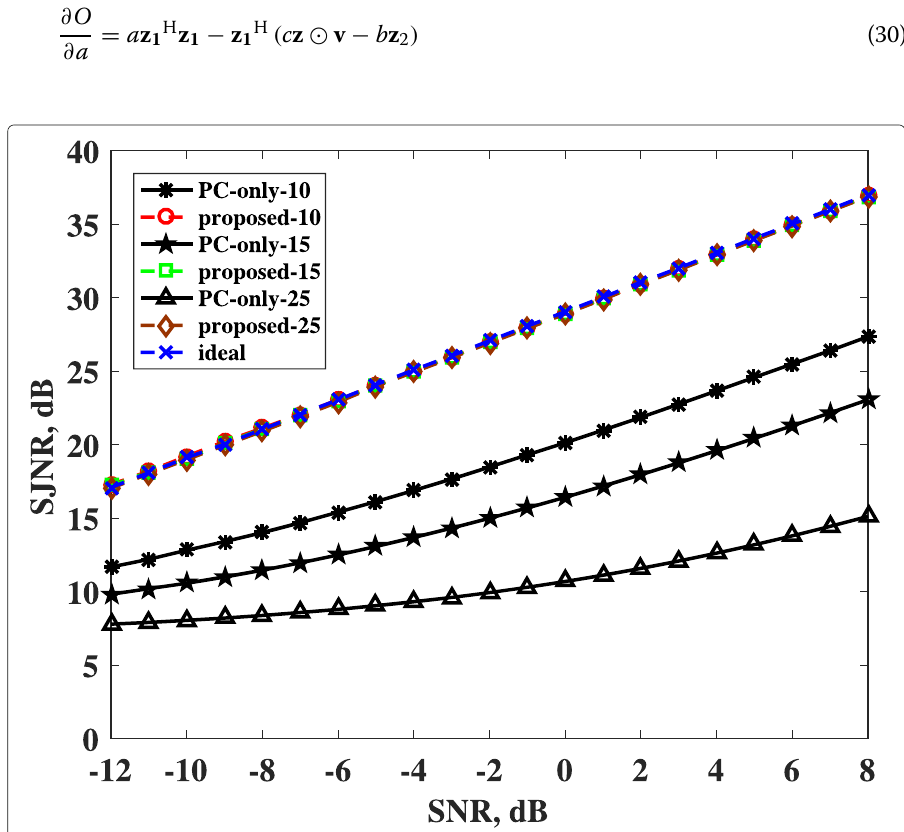
Fig. 6 The output SJNR under different input SNR in the NJ